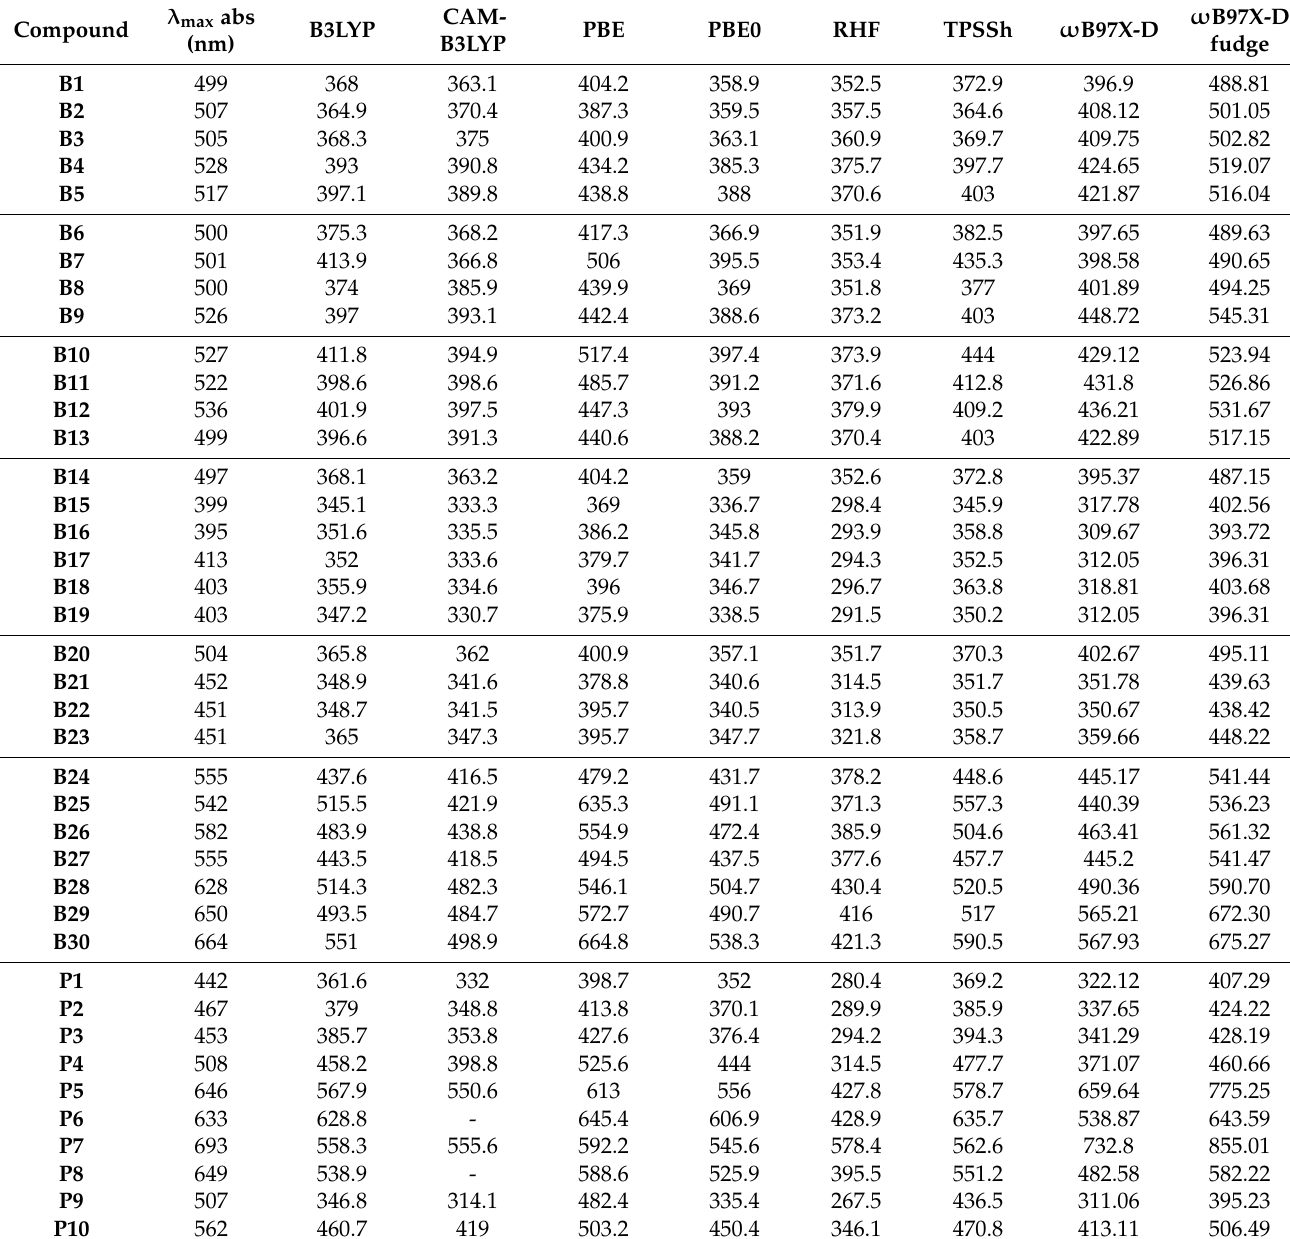
Table A1. Comparison of the experimental position of the 0-0 peak of the low-energy absorption band with the calculated ones for all investigated